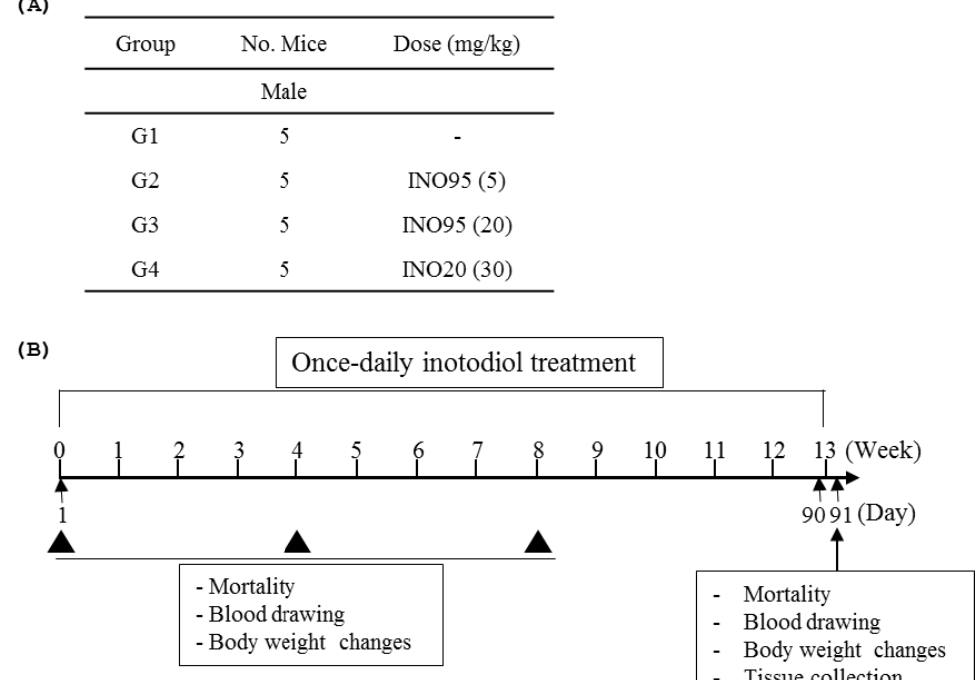
Figure 8. ( A ) Doses of inotodiol and,the number of animals per group of this study are shown. ( B ) Overall experimental design is